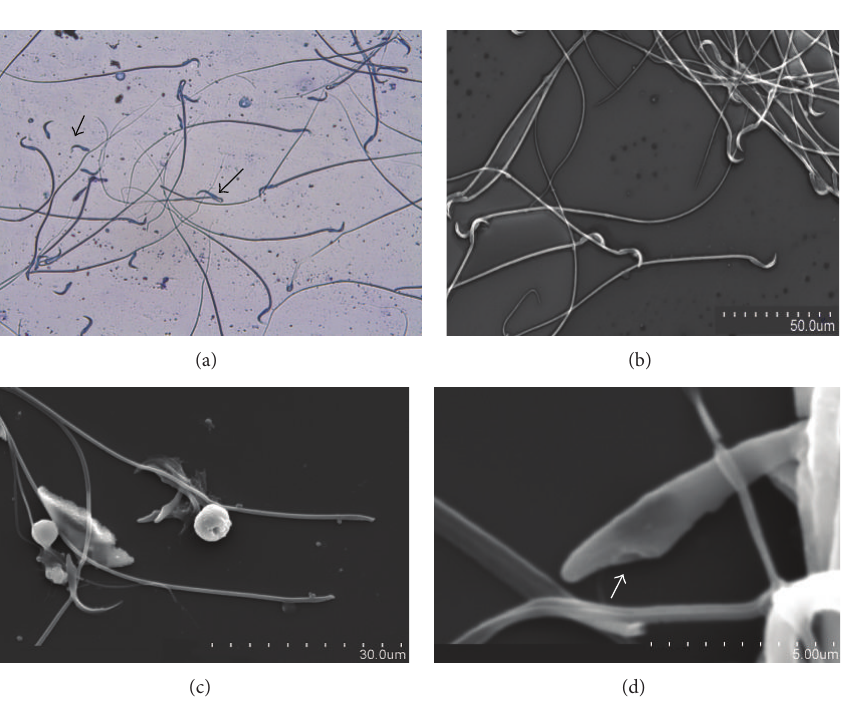
Figure 3: (a–d) Cauda epididymal fluid smear of untreated rats and rats treated with triptolide showing sperm head tail separation. (a) Sperms with head tail separation (short arrow) and midpiece coiling (long arrow) observed in cauda epididymal fluid of treated rat under light microscope at 400x, (b) sperms with no head tail separation observed in cauda epididymal fluid of untreated rat under SEM at 15.0 kV 9.6 mm × 600 SE, (c) sperms with head tail separation observed in cauda epididymal fluid of treated rat under SEM at 15.0kV 9.9 mm × 1.70 k SE, and (d) sperms with head tail separation observed in cauda epididymal fluid of treated rat under SEM at 15.0 kV 9.9 mm × 10k SE. Arrow indicates region of separation of middle